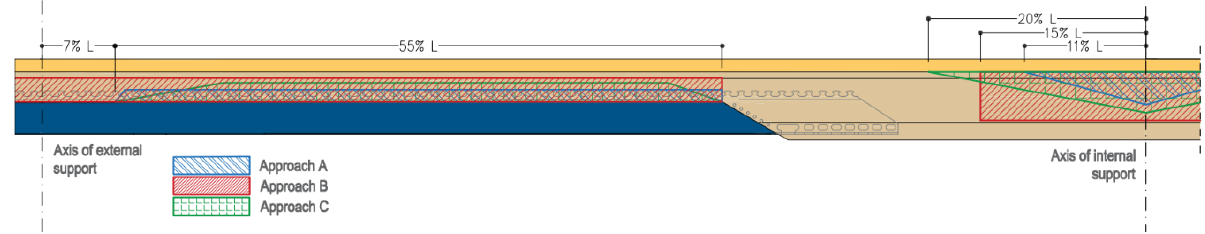
Figure 18: Comparison of cracked zones in the web in approaches A, B and C. Cracked zones in slabs are equal to the length of cracked zones in the top part of a web at the internal support.